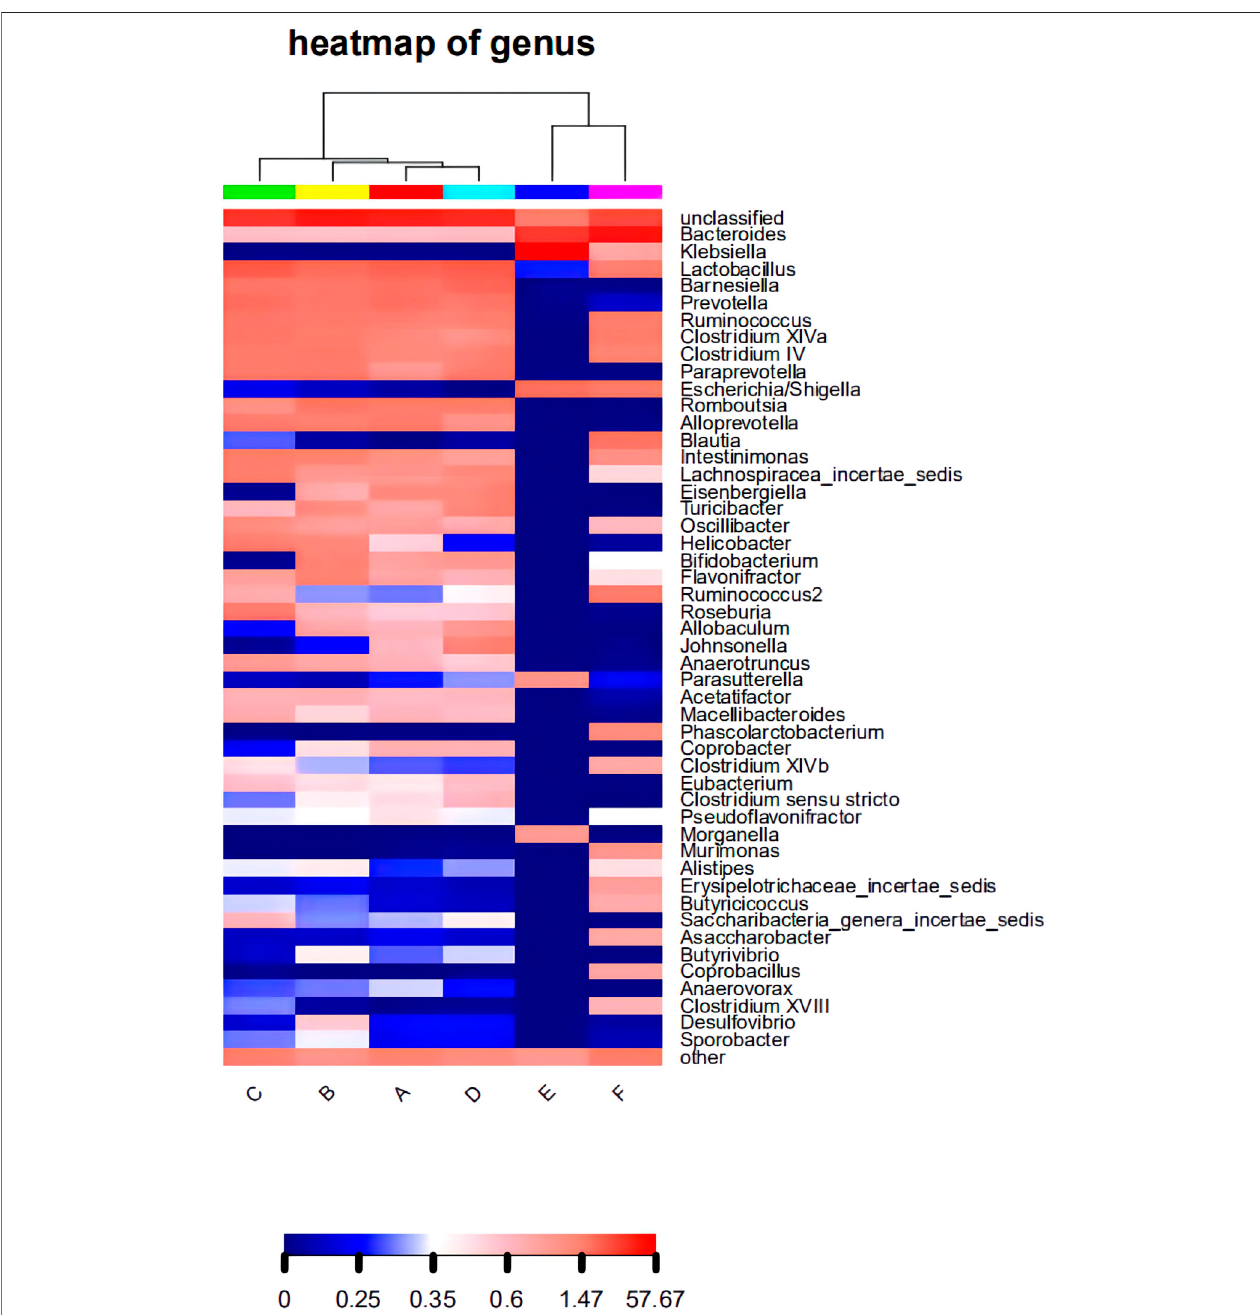
FIGURE3| The level ofabundance ofthetop 50generain each group ofsamples. Thesampleswere fi rst clusteredaccordingto theirsimilarity,and subsequently arranged laterally according to the clustering results. Similarly, taxa are also clustered according to the distribution similarity of each taxon in different samples, and arrangedverticallyaccording totheclusteringresults. Inthe fi gure, red represents thegenus withahigher abundance inthe corresponding sample, and bluerepresents the genus with a lower abundance.